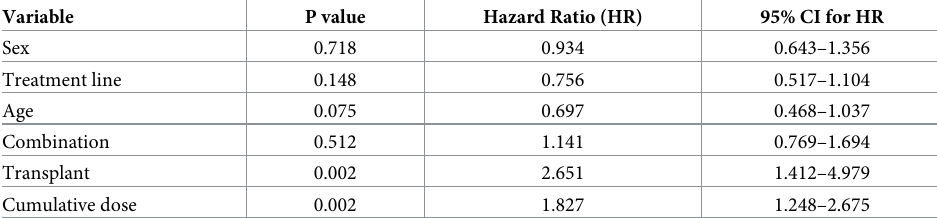
Table 6. Multivariate cox regression